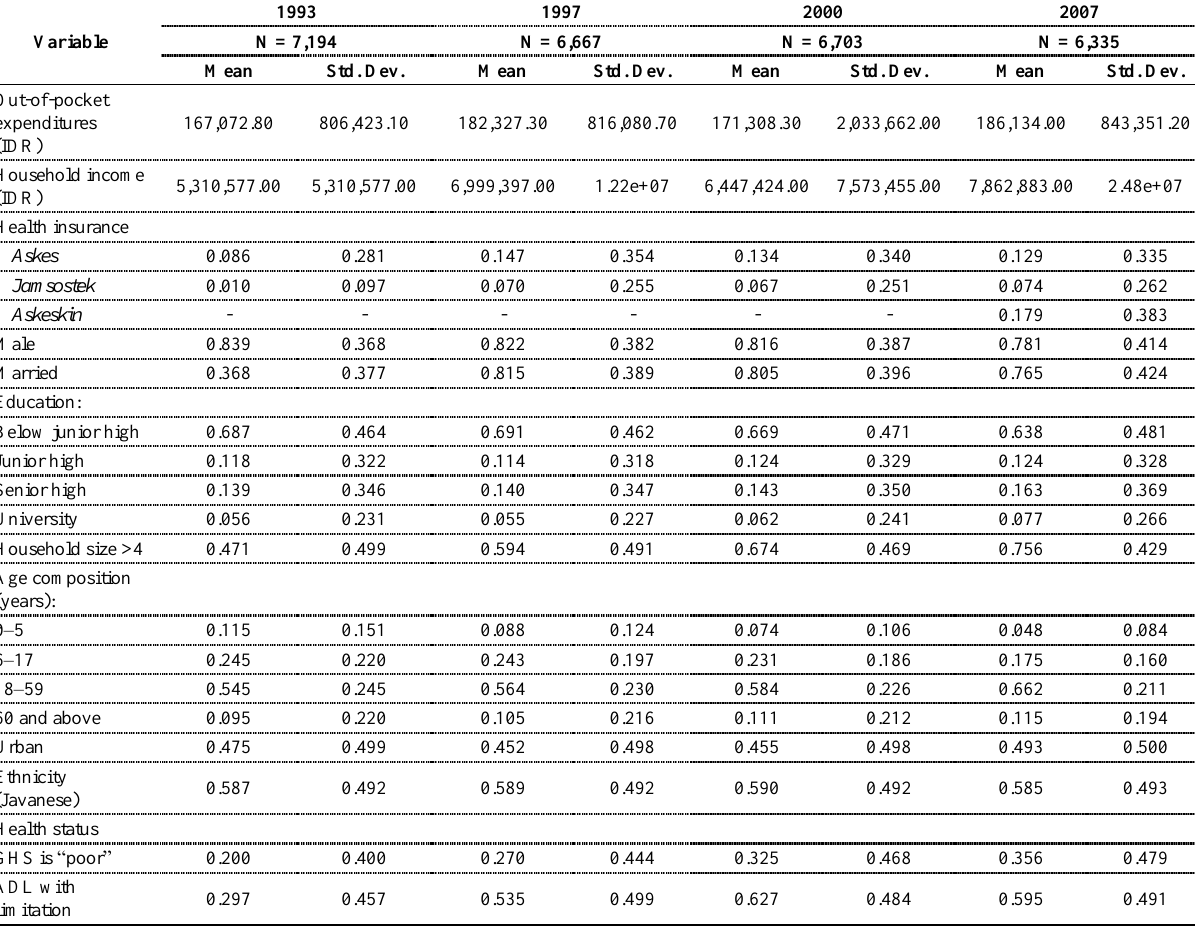
Table 2. Descriptive statistics IFLS household panel